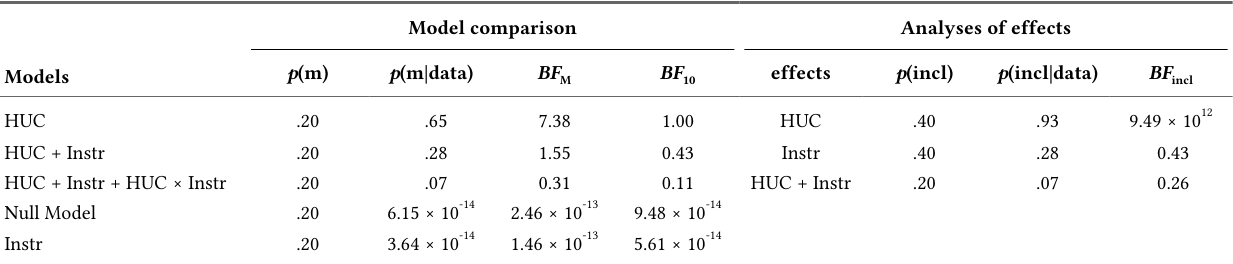
Results of the Bayesian Mixed Design ANOVA With the Within-Subject Factor Hundred-Unit Compatibility and Between-Subject Factor Instruction Model comparison Models